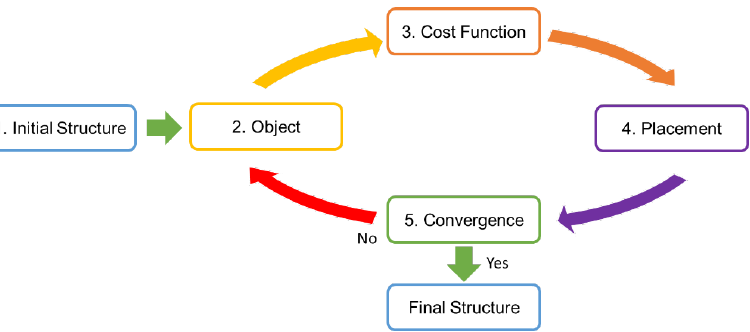
Figure 1. The main workflow of the microstructure generation framework comprising the following steps: (1) creation of an initial guess of the microstructure, (2) selection of the object to be placed from a library of candidate objects, (3) computation of the geometric and statistical cost functions, (4) placement of the object at an optimum location based on heuristics, and (5) assessment of convergence.